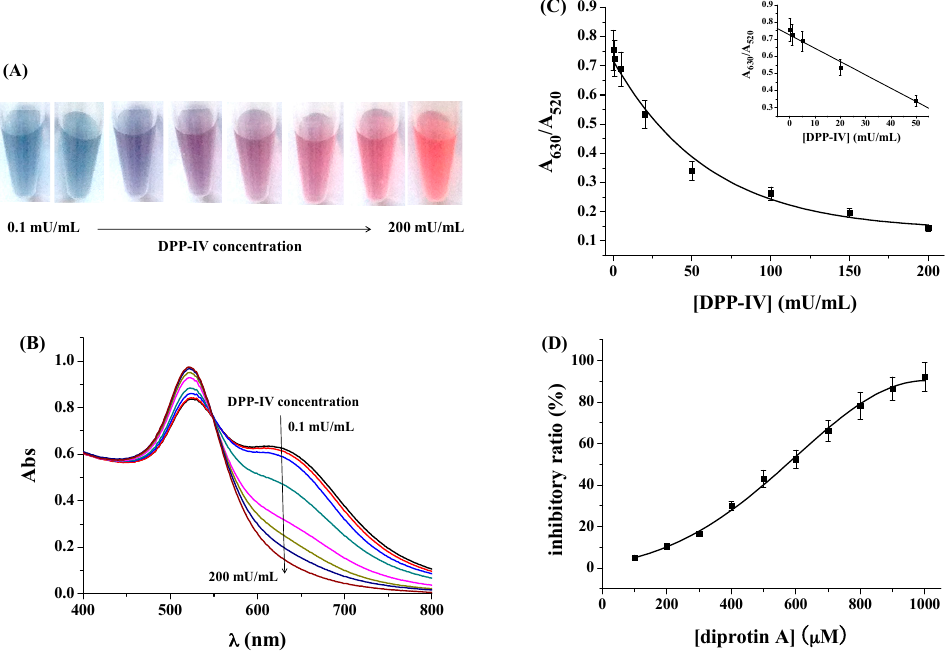
Figure 3. Photographic images ( A ) and UV–vis absorption spectra; ( B ) of AuNPs in the presence of peptide and various concentrations of DPP-IV (0.1, 1, 5, 20, 50, 100, 150 and 200 mU/mL); ( C ) Dependence of the A 630 /A 520 on the DPP-IV concentration. The final concentrations of AuNPs and peptide were 3.6 nM and 2 μ M, respectively; ( D ) Inhibitory ratio of different concentrations of diprotin A (100, 200, 300, 400, 500, 600, 700, 800, 900 and 1000 μ M) on the DPP-IV (50 mU/mL) activity.